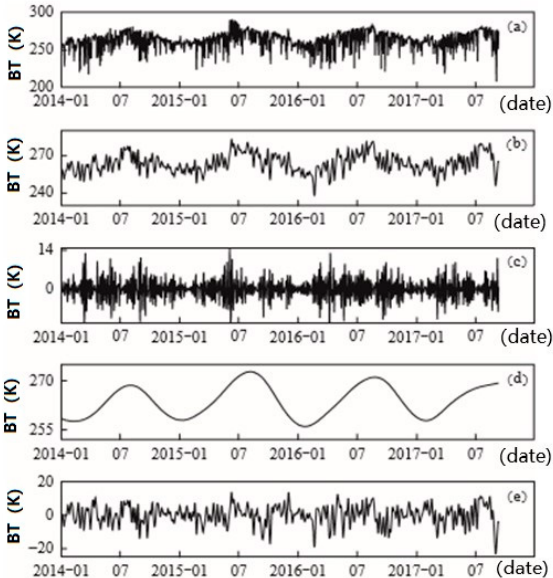
Figure 1. Results of wavelet transformation of the temperature of brightness blackbody (TBB). ( a ) Original record of brightness temperature; ( b ) result with second-order scale analysis; ( c ) details of the second-order wavelet; ( d ) results with seventh-order scale analysis; and ( e ) difference between second-order scale analysis and seventh-order scale analysis.